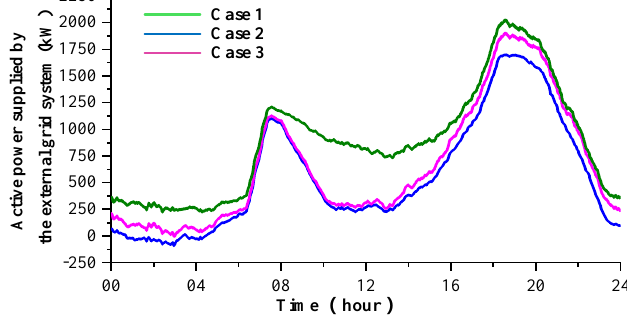
Figure 7. Active power supplied by the external grid system.